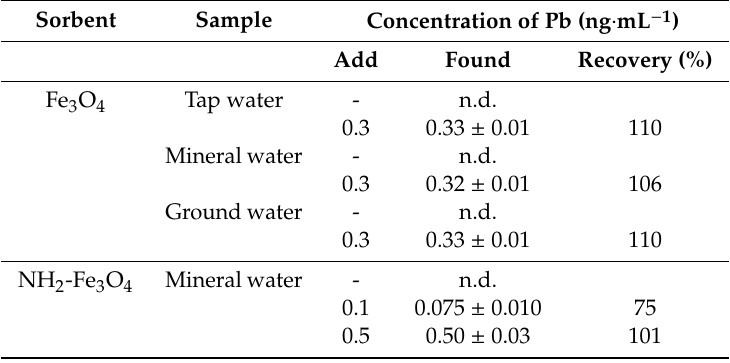
Table 2. Determination of Pb in the environmental samples (n = 3).